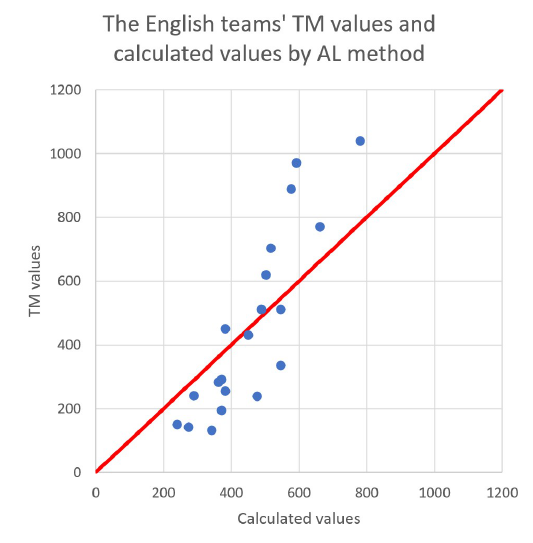
Figure 3. Correlation between estimated values and real TM values of the English teams.